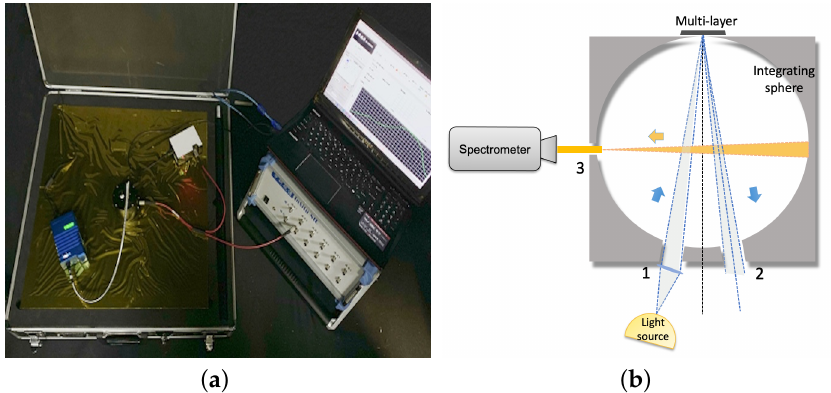
Figure 3. ( a ) Laboratory test setup. ( b ) Schematic. Numbers 1, 2 and 3 correspond to the three windows. Light source from window 1 entering the integrating sphere.